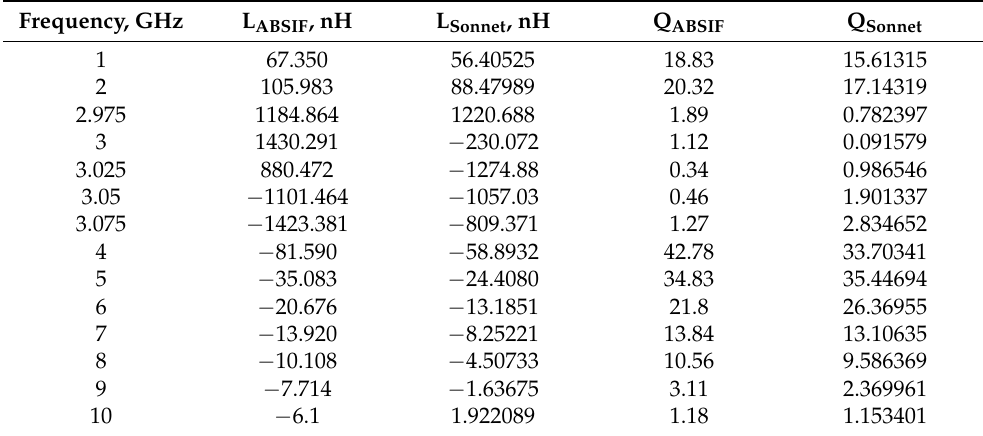
Table 7. L and Q vs. f for 16 turns spiral inductor: comparison of the results obtained by ABSIF and